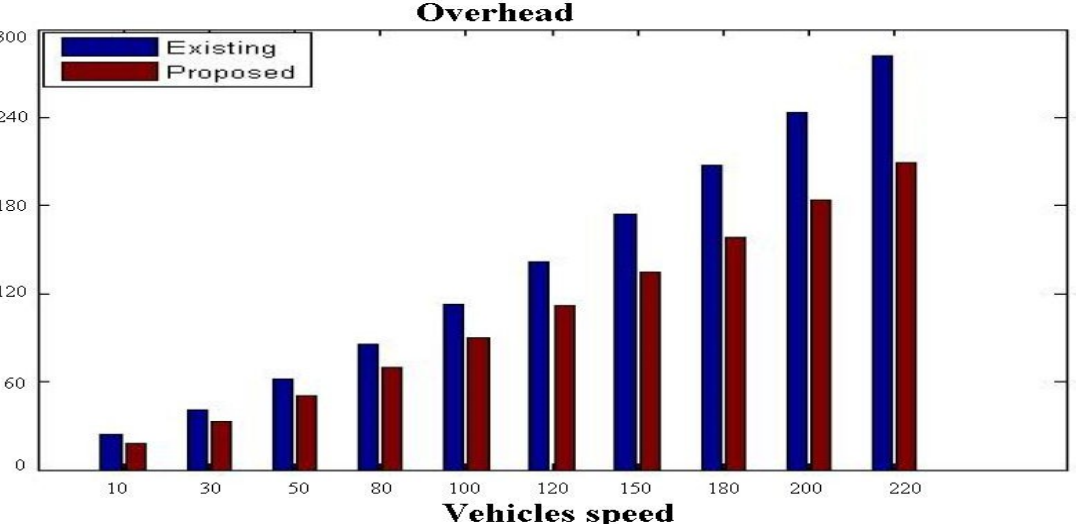
Table 5. Aggregation time.